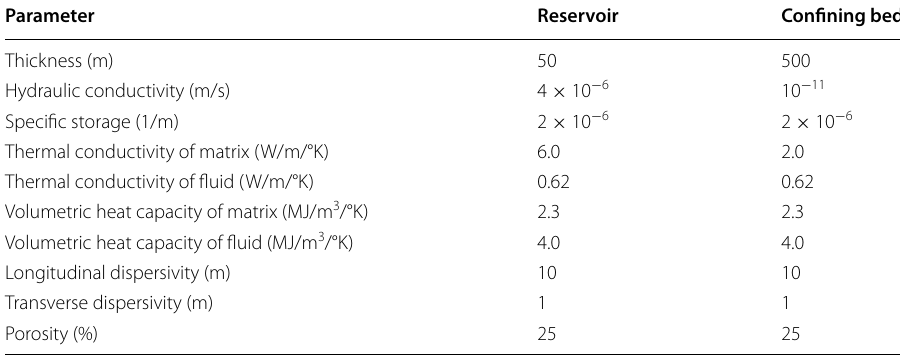
Table 1 Model thermal and hydraulic